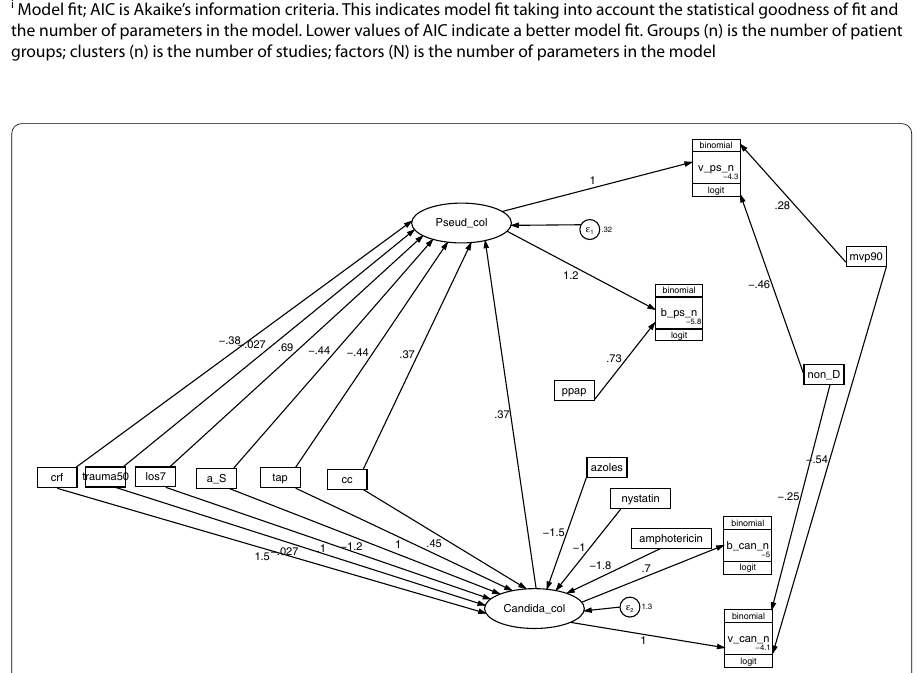
Fig. 4 GSEM of the interaction model in relation to Pseudomonas and Candida infection data. Candida col and Pseudomonas col (ovals) are latent variables representing Candida and Pseudomonas colonization, respectively. The variables in rectangles are binary predictor variables representing the group level exposure to the following; patient selection for candidemia risk factors (CRF); trauma ICU setting (trauma50), mean or median length of ICU stay 7 days (los7), exposure to a topical anti-septic (a_S), exposure to TAP ≥ (tap), concurrency of a control group with an antibiotic-based intervention group (CC), exposure to a non-decontamination based prevention method (non-D), use of mechanical ventilation for more than 90% (mvp90) or exposure to PPAP (ppap). Note that the model factorizes exposures from compound regimens (e.g. SDD and SOD, which combine TAP, an antifungal together with or without PPAP) into singleton TAP, PPAP and anti-fungal exposures. The circles contain error terms. The three part boxes represent the binomial data for Candida and Pseudomonas VAP (v_can_n, v_ps_n) and candidemia (b_can_n) or bacteremia (b_ps_n) counts with the number of patients as the denominator which is logit transformed using the logit